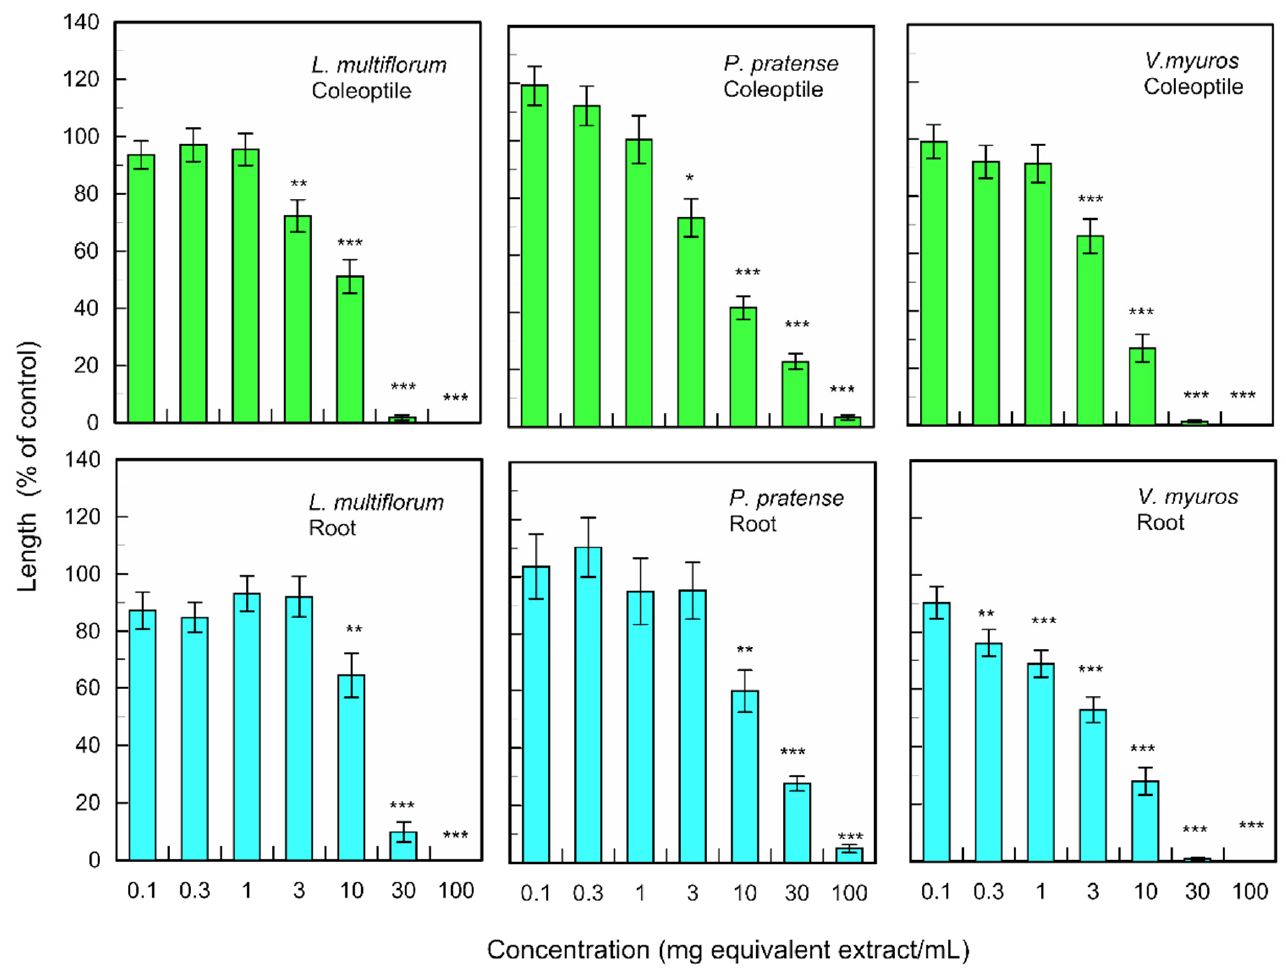
Figure 3. Effects of the extracts of M. glyptostroboides leaves on the growth of roots and coleoptiles of L. multiflorum, P. pretense , and V. myuros . Concentrations of tested samples corresponded to the extracts obtained from 0.1, 1, 3, 10, 30, 100, and 300 mg dry weight equivalent extract per mL. Means ± SE from three independent experiments with 10 plants for each determination are shown. Asterisks indicate significant differences between control and treatment: *, p < 0.05, **, p < 0.01, ***, p < 0.001.